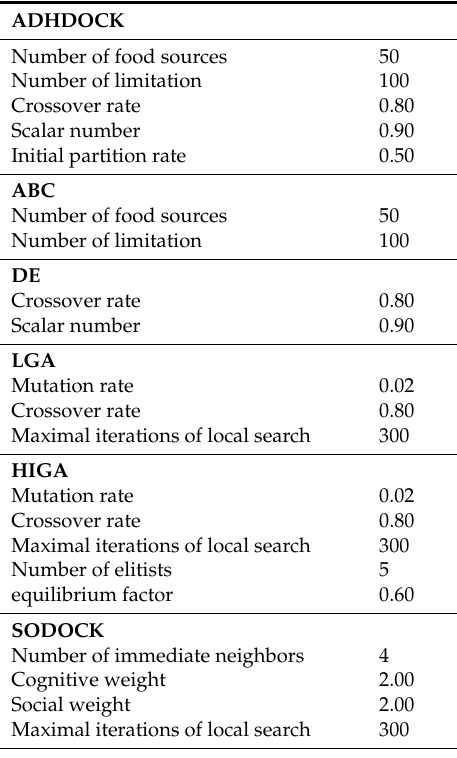
Table 1. Parameters of six tested